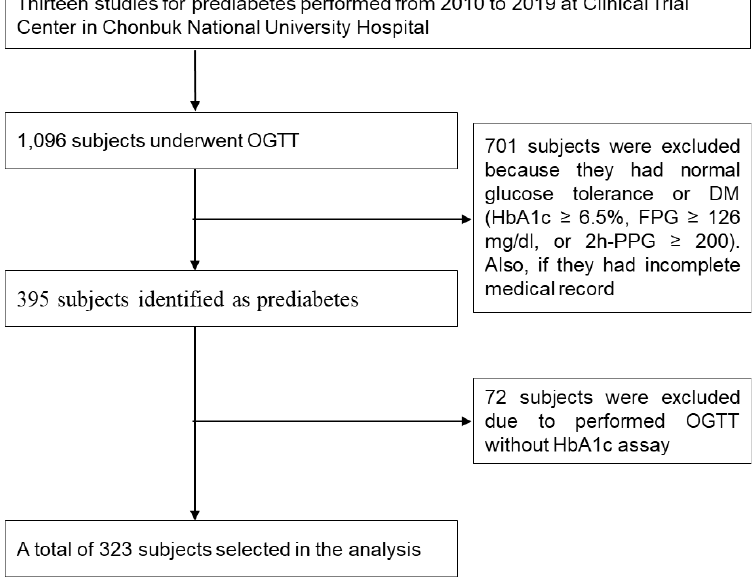
Figure 1. Flow diagram of data collection.